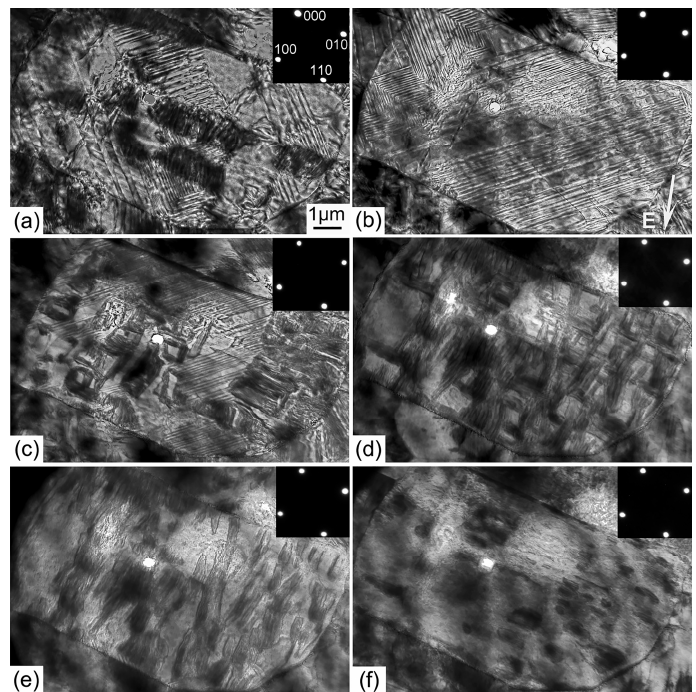
Figure 11. In situ TEM observation during electrical poling: ( a ) 8 kV/cm; ( b ) 10 kV/cm; ( c ) 14 kV/cm; ( d ) 18 kV/cm. The direction of poling fields is indicated by the bright arrow in ( b ). Representative selected area diffraction pattern at each poling field are shown in the insets. Adapted from [70], with permission from © 2013 AIP Publishing LLC.